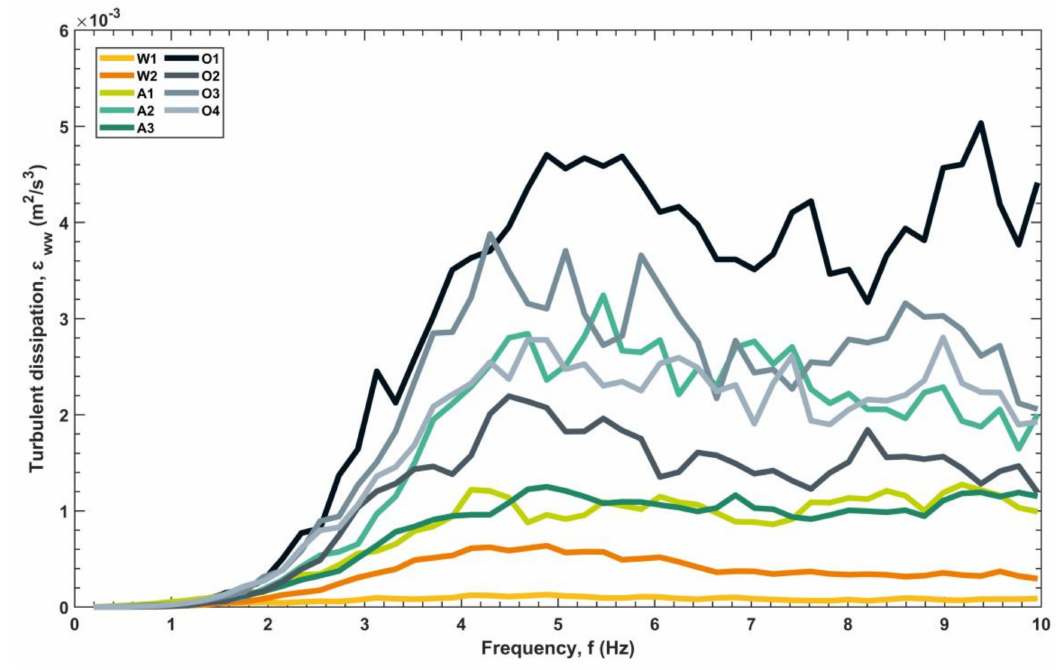
(cid:16) (cid:17) m 2 /s 3 against frequency calculated for